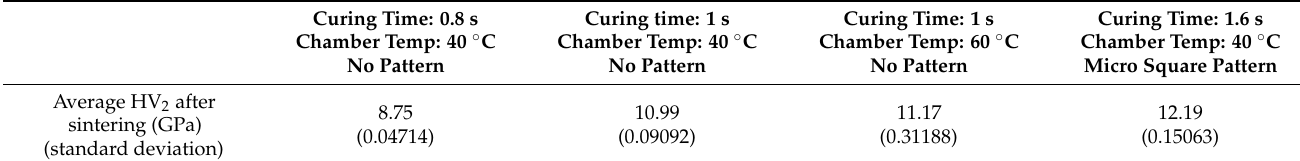
Table 4. Vickers